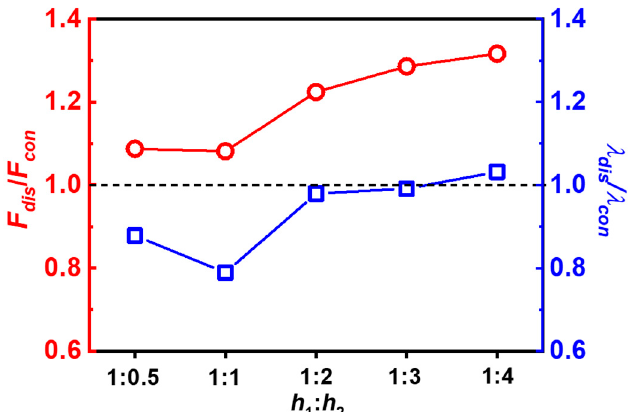
Figure 4. The rupture force ratio ( F dis / F con ) and normalized rupture stretch ratio ( λ dis / λ con ) as functions of spacing ratios h 1 : h 2 . The F dis and F con represent the rupture forces in fracture specimens containing dispersed cuts and continuous cuts, respectively. The λ dis and λ con denote the rupture stretch ratios in fracture experiments containing dispersed cuts (D-cut gels) and continuous cuts (C-cut gels), respectively.